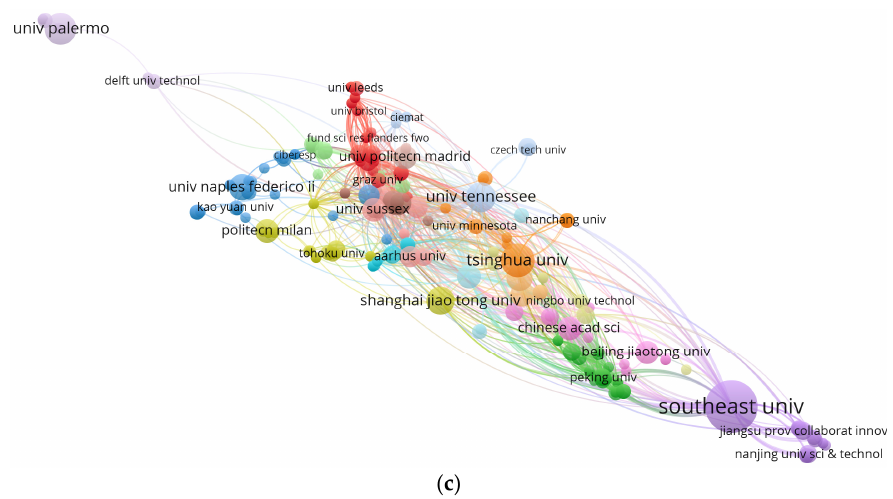
Figure 2. Visualization of risky riding behaviors in e-bike studies: ( a ) the citation network among productive authors; ( b ) the co-authorship network among productive authors; ( c ) the collaboration network among research institutions.